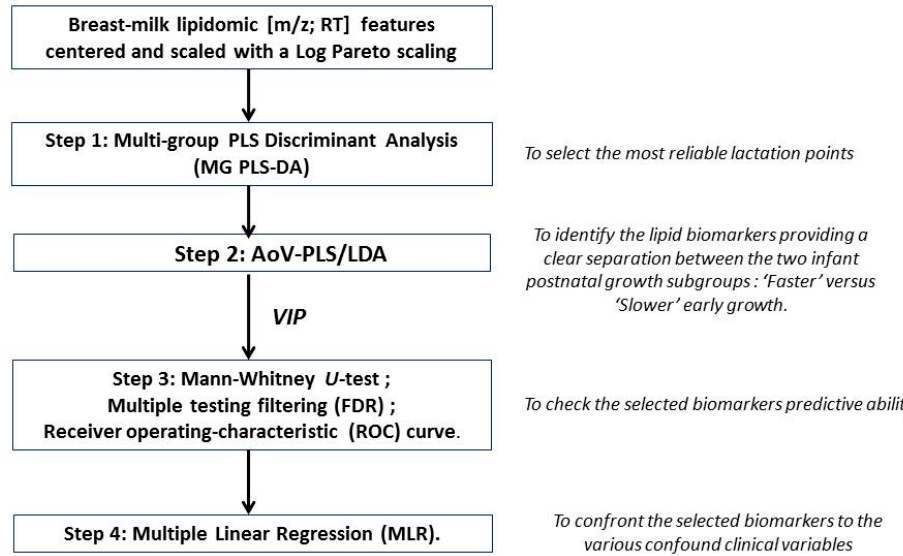
Figure 2. Statistical workflow applied on breast-milk Liquid Chromatography–High-Resolution-Mass Spectrometry profiles obtained in positive and negative ionization mode.